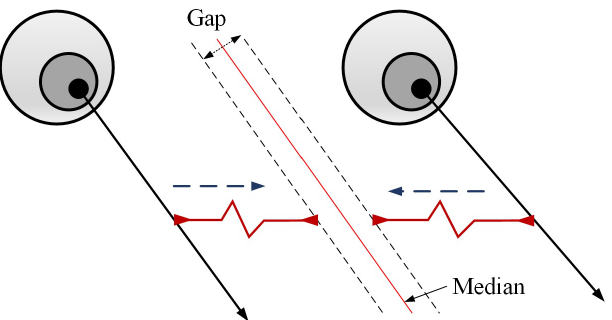
Figure 3. The principle of gaze consistency (the gap is usually